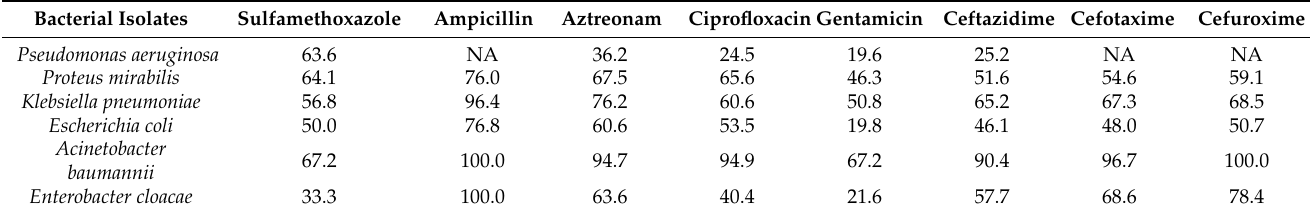
Table 6. Gram-negative bacterial resistance rates in patients aged more than 63 years.